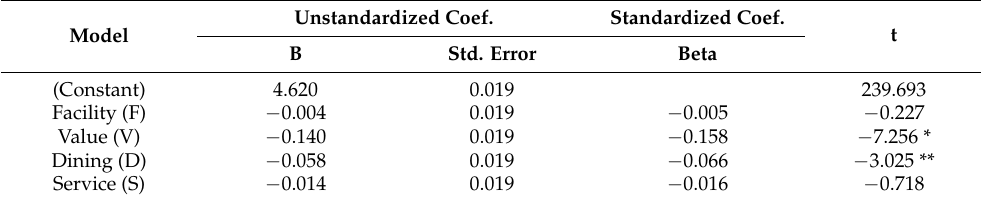
Table 5. Results of linear regression